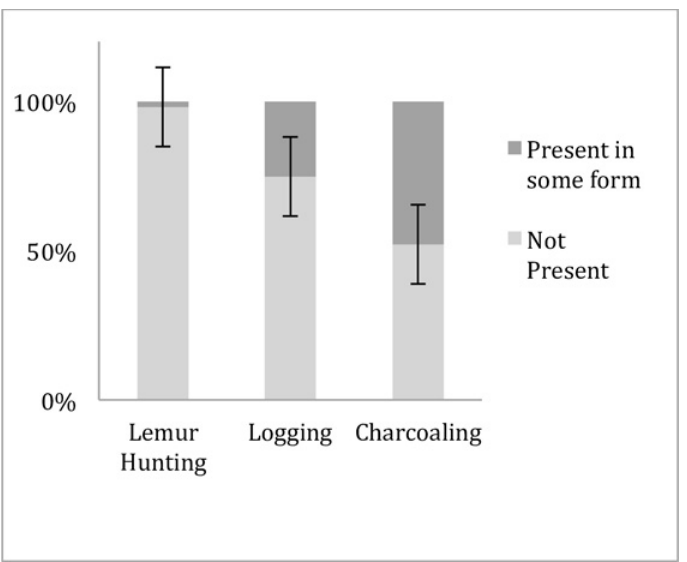
Fig 2. Local perceptions of illegal biodiversity exploitation rates. Error bars denote standard error. All activities are illegal under the rule of law in Madagascar.